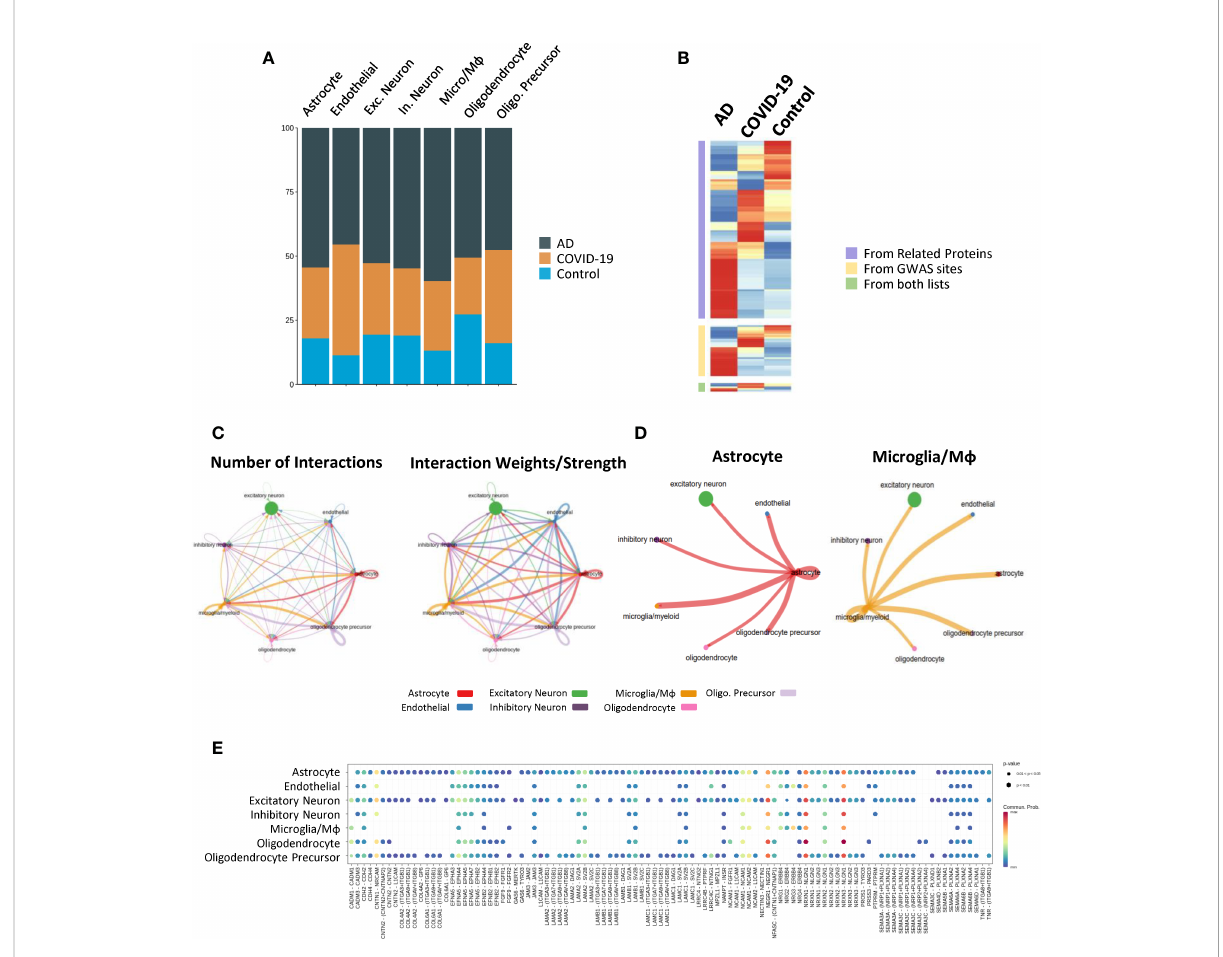
FIGURE 5 View of subtypes and cell – cell communication. (A) Relative abundance of each cell type in the AD, COVID-19 and control groups. (B) AD neuron score overlaid on UMAP showing the expression of AD-related gene sets in the cells. The right panels show the same value in each group. (C, D) Circle network and heatmap diagram of signi fi cant cell – cell interaction pathways. Arrows and edge colour indicate direction (ligand: receptor), and edge thickness indicates the sum of numbers (left) and weights (right) paths between populations. Network shown by cell types and heatmap by clusters. (E) Dot plot showing the key ligands in outgoing signalling, NCAM, the pattern of the sub-population as